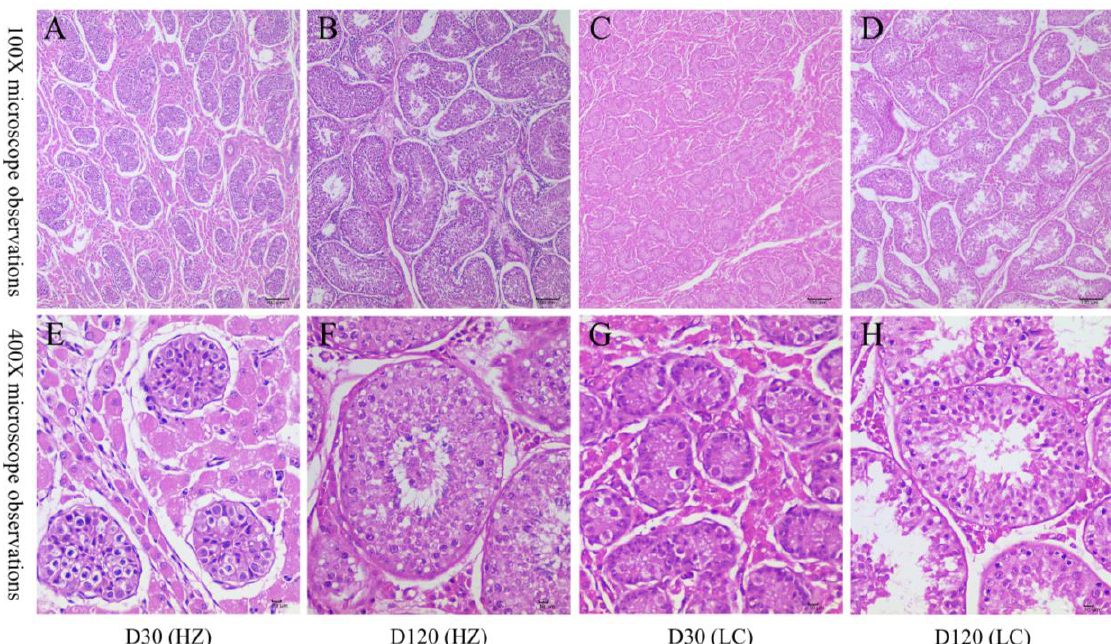
Figure 1. Histological evaluation of HZ and LC pig testicular tissues at 30 and 120 days old. The morphology of each sample was observed under light microscopy: ( A – D ) represent the testicular cross-sections of 30-day-old HZ, 120-day-old HZ, 30-day-old LC, and 120-day-old LC pig at 100x magnification, respectively; ( E – H ) represent the testicular cross-sections of 30-day-old HZ, 120-day-old HZ, 30-day-old LC, and 120-day-old LC pig at 400× magnification, respectively.